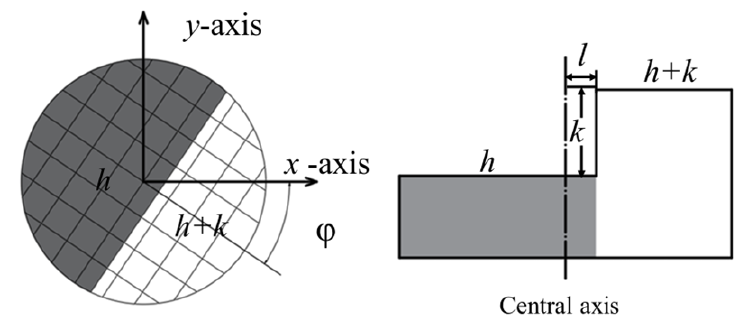
Figure 3. The step model of Zernike moment.